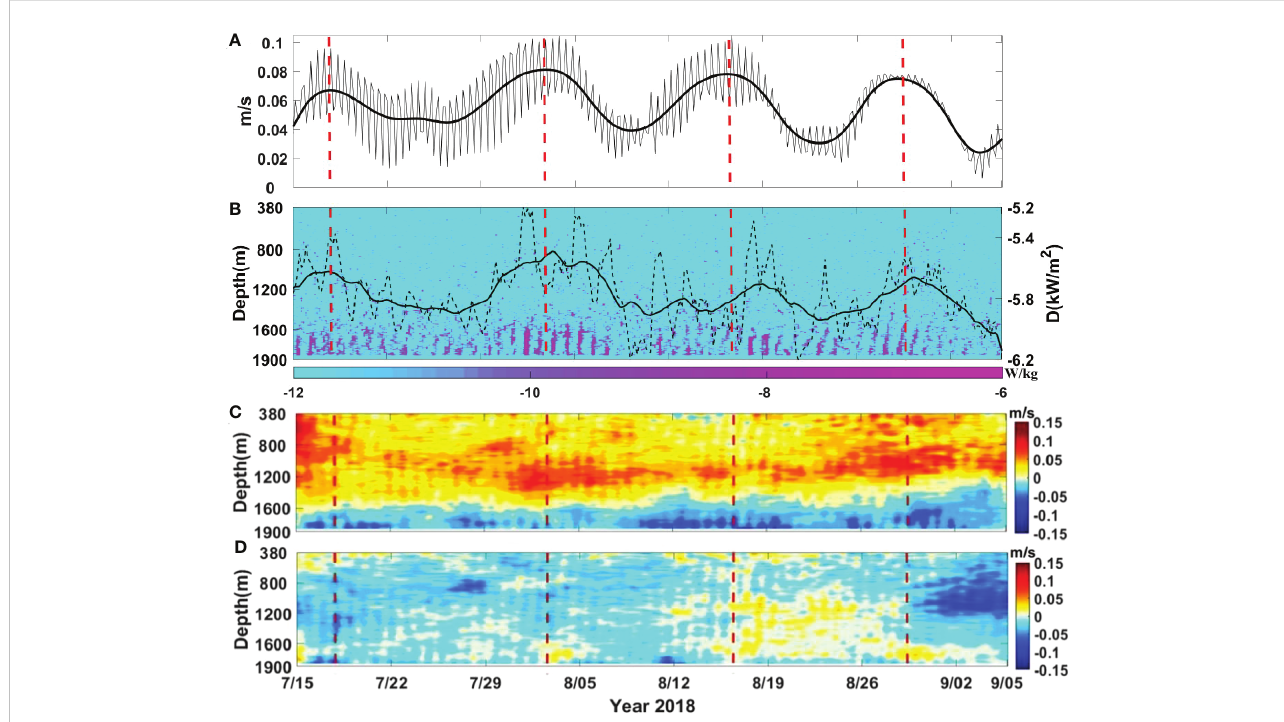
FIGURE 6 (A) Time series of diurnal velocity variances ( u 2 + v 2 ) 1/2 averaged over depths of 1600 and 1840 m. The thick line is a smoothed result. (B) The dissipation rate ϵ based on equation (4). The black dotted line is depth-integrated dissipation rate, and the thick line is its smoothed result. (C, D) Time-depth maps of low-pass fi ltered along-slope (C) and cross-slope (D) velocities. The vertical dash lines indicate four diurnal